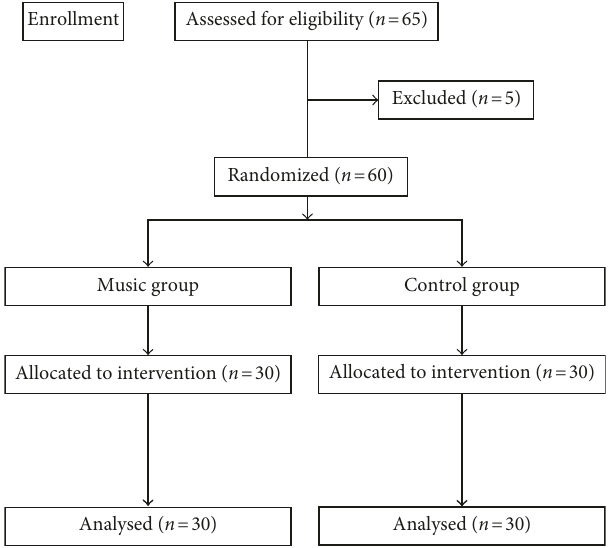
Assessed for eligibility ( n = 65)